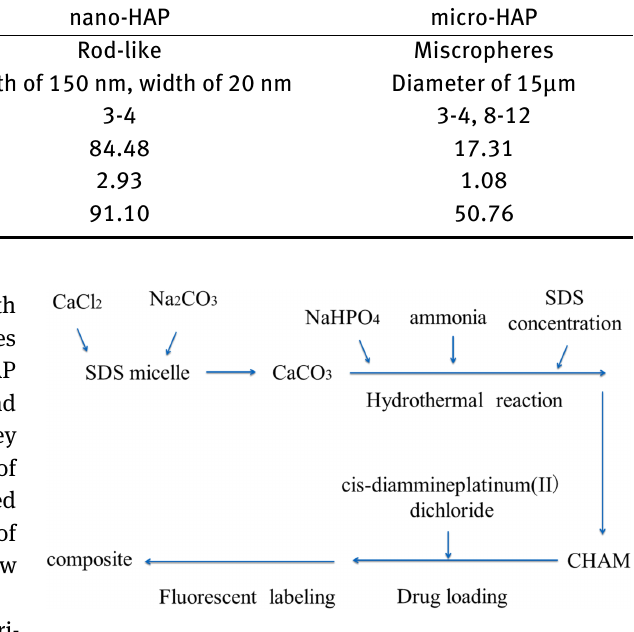
Figure 3: The process of CHAM synthesizing, drug loading and fluorescent